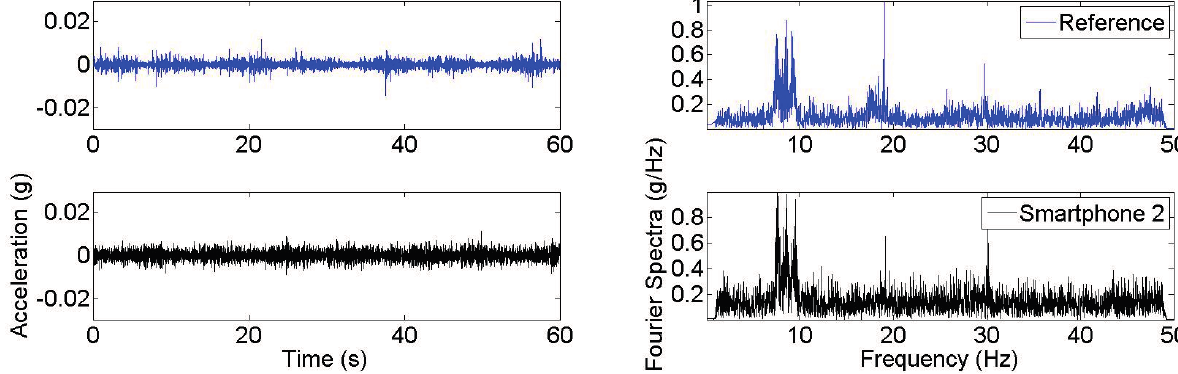
Figure 12. Acceleration time histories and Fourier spectra samples from pedestrian-induced